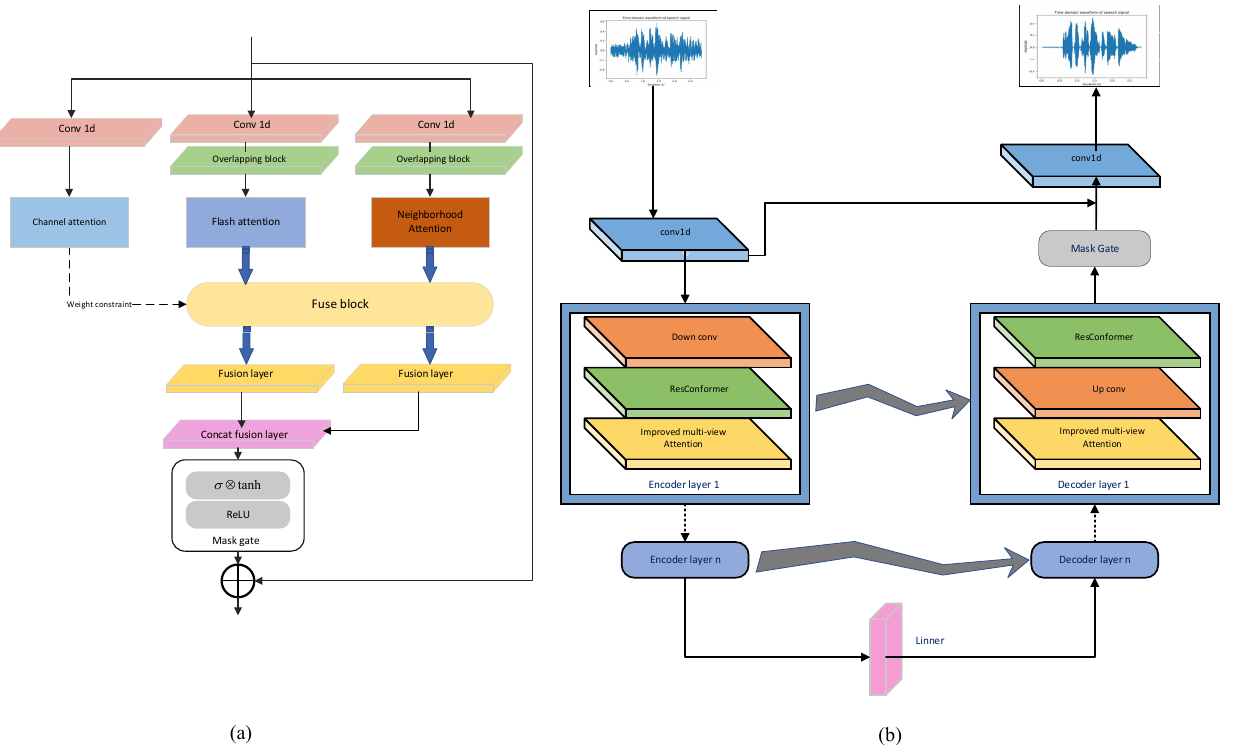
Figure 6. ( a ) Structure of the improved MA module; and ( b ) structure of the AF ‐ MANNER.